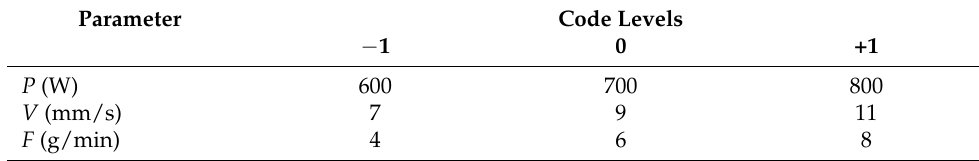
Table 2. Process parameters and levels.